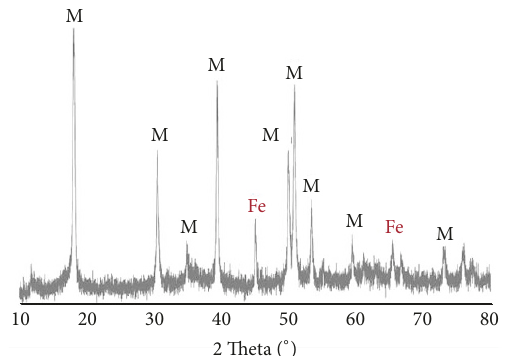
Figure 7: XRD analysis of the API 5L X52MS steel exposed to solution 284-B for 96 h (M: mackinawite). Figure 8: XRD analysis of the API 5L X52MS steel exposed to solution 284-B for 35 days (M: